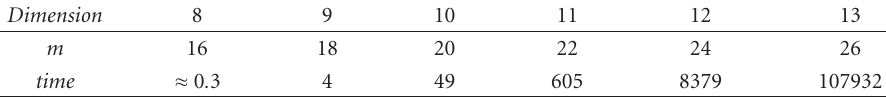
Table 4.1. Search results of 6 di ff erent dimensional pattern sets by exhaustive search. Dimension